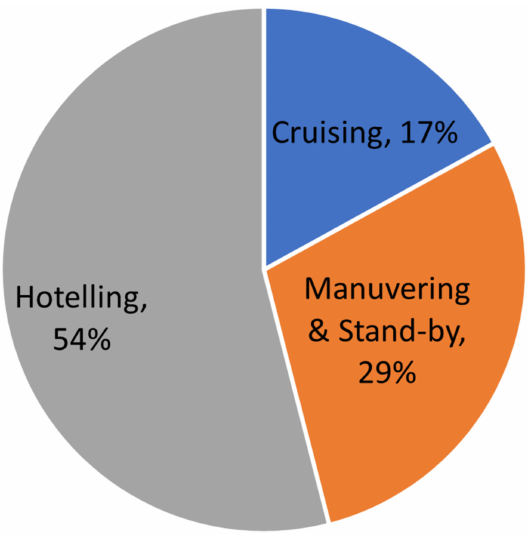
Figure 5. Share of different marine activities in NOx